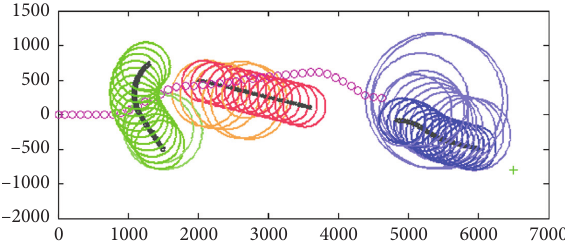
Figure 7: Simulation of variable-speed multiple obstacles collision avoidance.